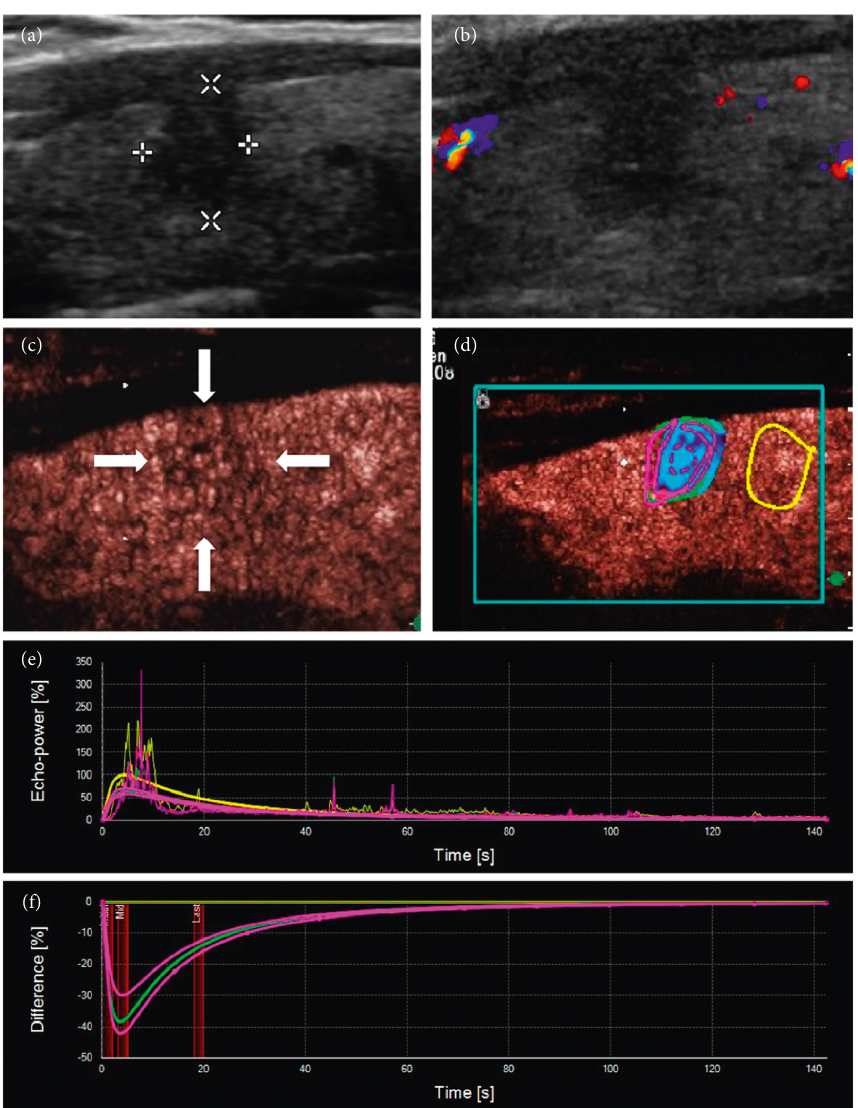
Figure 6: (a, b) A 33-year-old male was found to have a solid nodule with very low echo near to the front capsule of the thyroid. The nodule had irregular margin and a taller-than-wide shape. The discontinuity of anterior capsule indicated extrathyroidal invasion, and no blood flow signal was detected in the nodule. The nodule was classified as TI-RADS 5. (c) CEUS showed that the whole nodule had uneven low enhancement and unclear margin, but had no ring enhancement. (d–f) SonoLiver software was used to analyze the contrast video. According to the analysis results, the nodule was considered to be a PTC. Postoperative pathology confirmed this